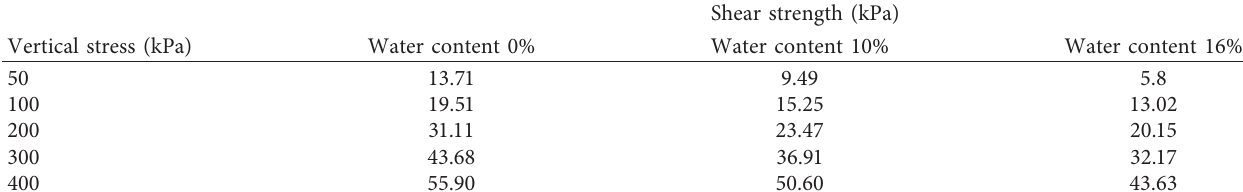
Table 2: Shear strength of specimens at density of 1.23g/cm 3 .